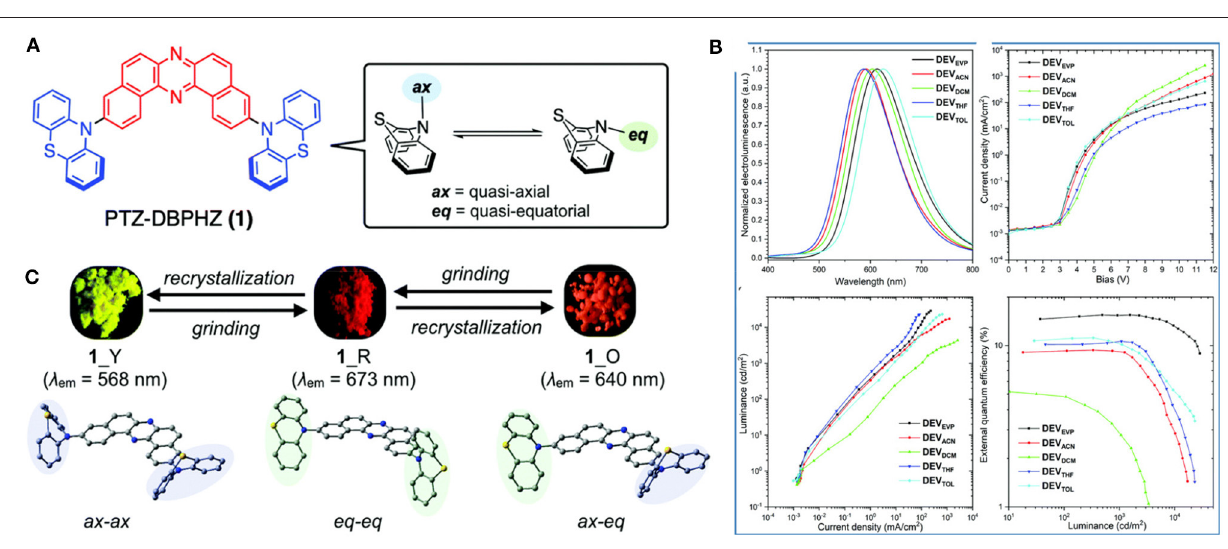
FIGURE 14 | (A) Chemical structure of 1 with respective conformers (B) A comparison of characteristics of OLED devices and EL spectra (C) MCL properties in various conformers. Reproduced with permission from Data et al. (2019). Copyright © The Royal Society of Chemistry. were fabricated and a maximum EQE of 18.8% was achieved for QBP-DMAC-based OLEDs, which is among the highest efficiencies of TADF-AIE-MCL active organic